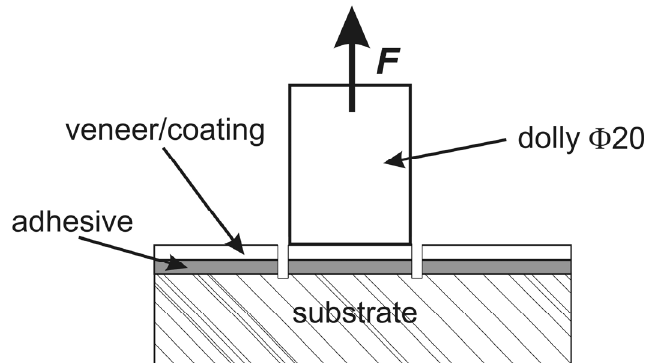
Figure 2. Pull-off specimen: F— force direction. Figure 2. Pull-o ff specimen: F— force direction.